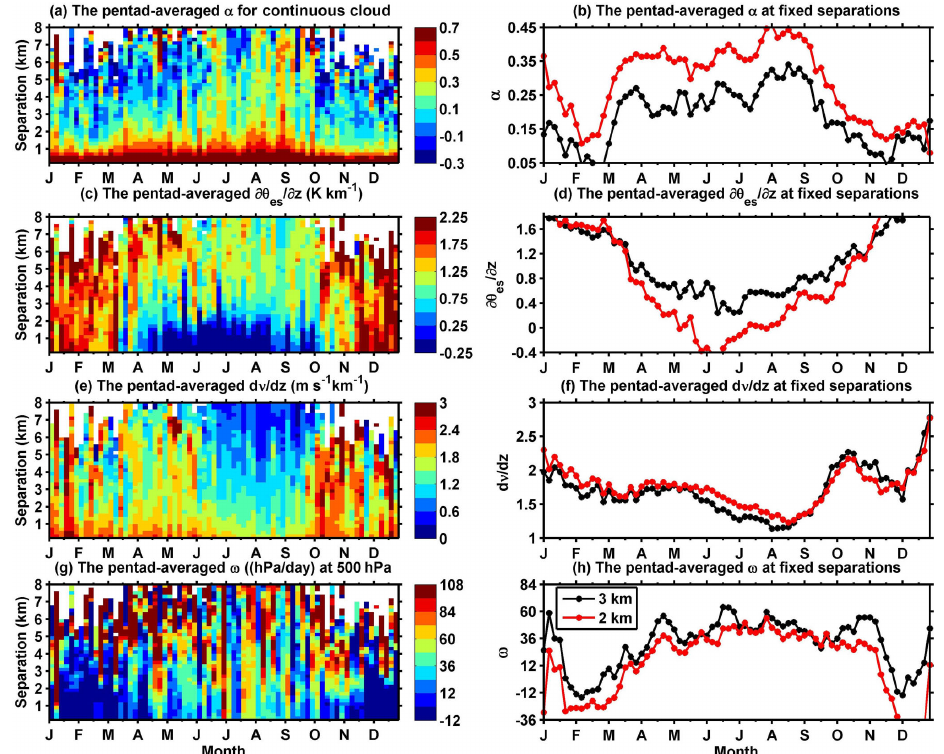
Figure 3. The monthly variations in the pentad-averaged (a) cloud overlap parameter, α , (c) conditional instability to moist convection, ∂θ es /∂z (Kkm − 1 ), (e) wind shear, d V/ d z (ms − 1 km − 1 ), and (g) vertical velocity ω (hPaday − 1 ) at 500hPa, for the contiguous cloud layers over the TP. The monthly variations in the pentad-averaged (b) α , (d) ∂θ es /∂z , (f) d V/ d z , and (h) ω for the contiguous clouds for the layer separation of 2km (red) and 3km